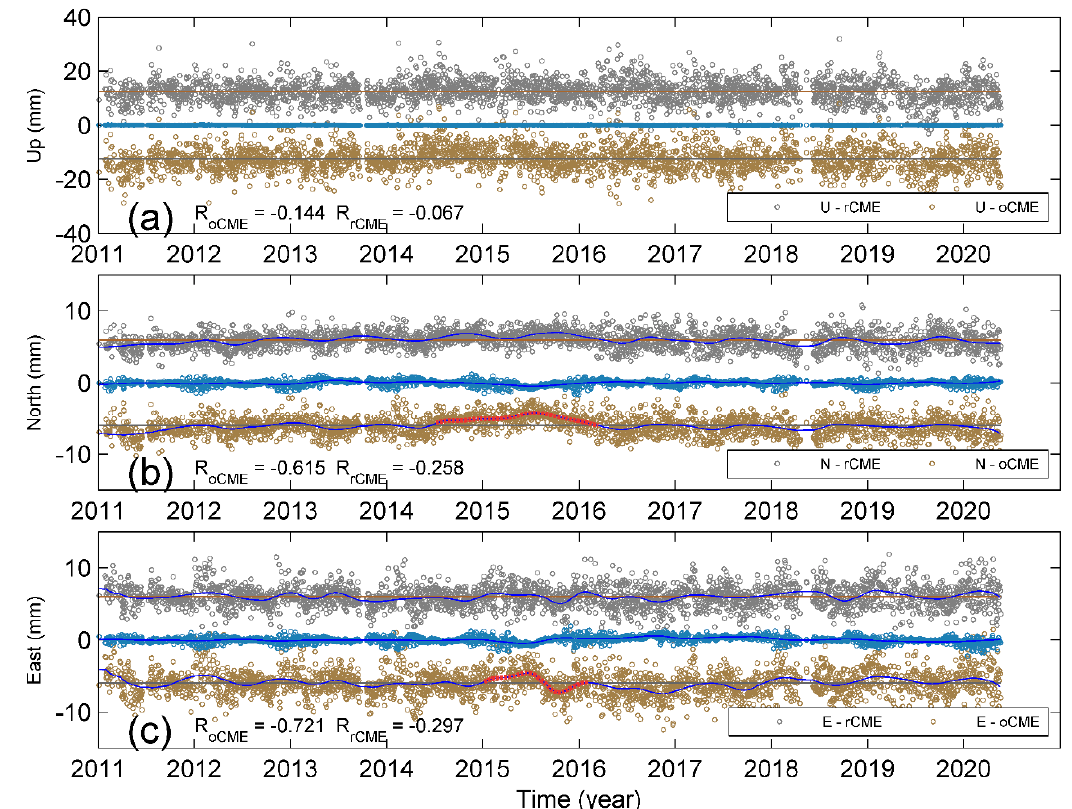
Figure 5. Comparison between rCME correction (gray circles) and oCME correction (yellow circles) for ( a ) up, ( b ) north, and ( c ) east components of YNYA; also shown are the weighted residuals (blue circles) of three components of XIAG, which are weakly correlated with all the other stations. The curves in blue are non-linear trends. The R oCME and R rCME are correlation coe ffi cients between residual time series of XIAG and that after oCME and rCME corrections of YNYA. The dashed red curves in oCME-corrected north and east components denote the spurious transient-like signals. Table 2. Variances of the detrended GPS time series corrected with rCMEs and oCMEs.